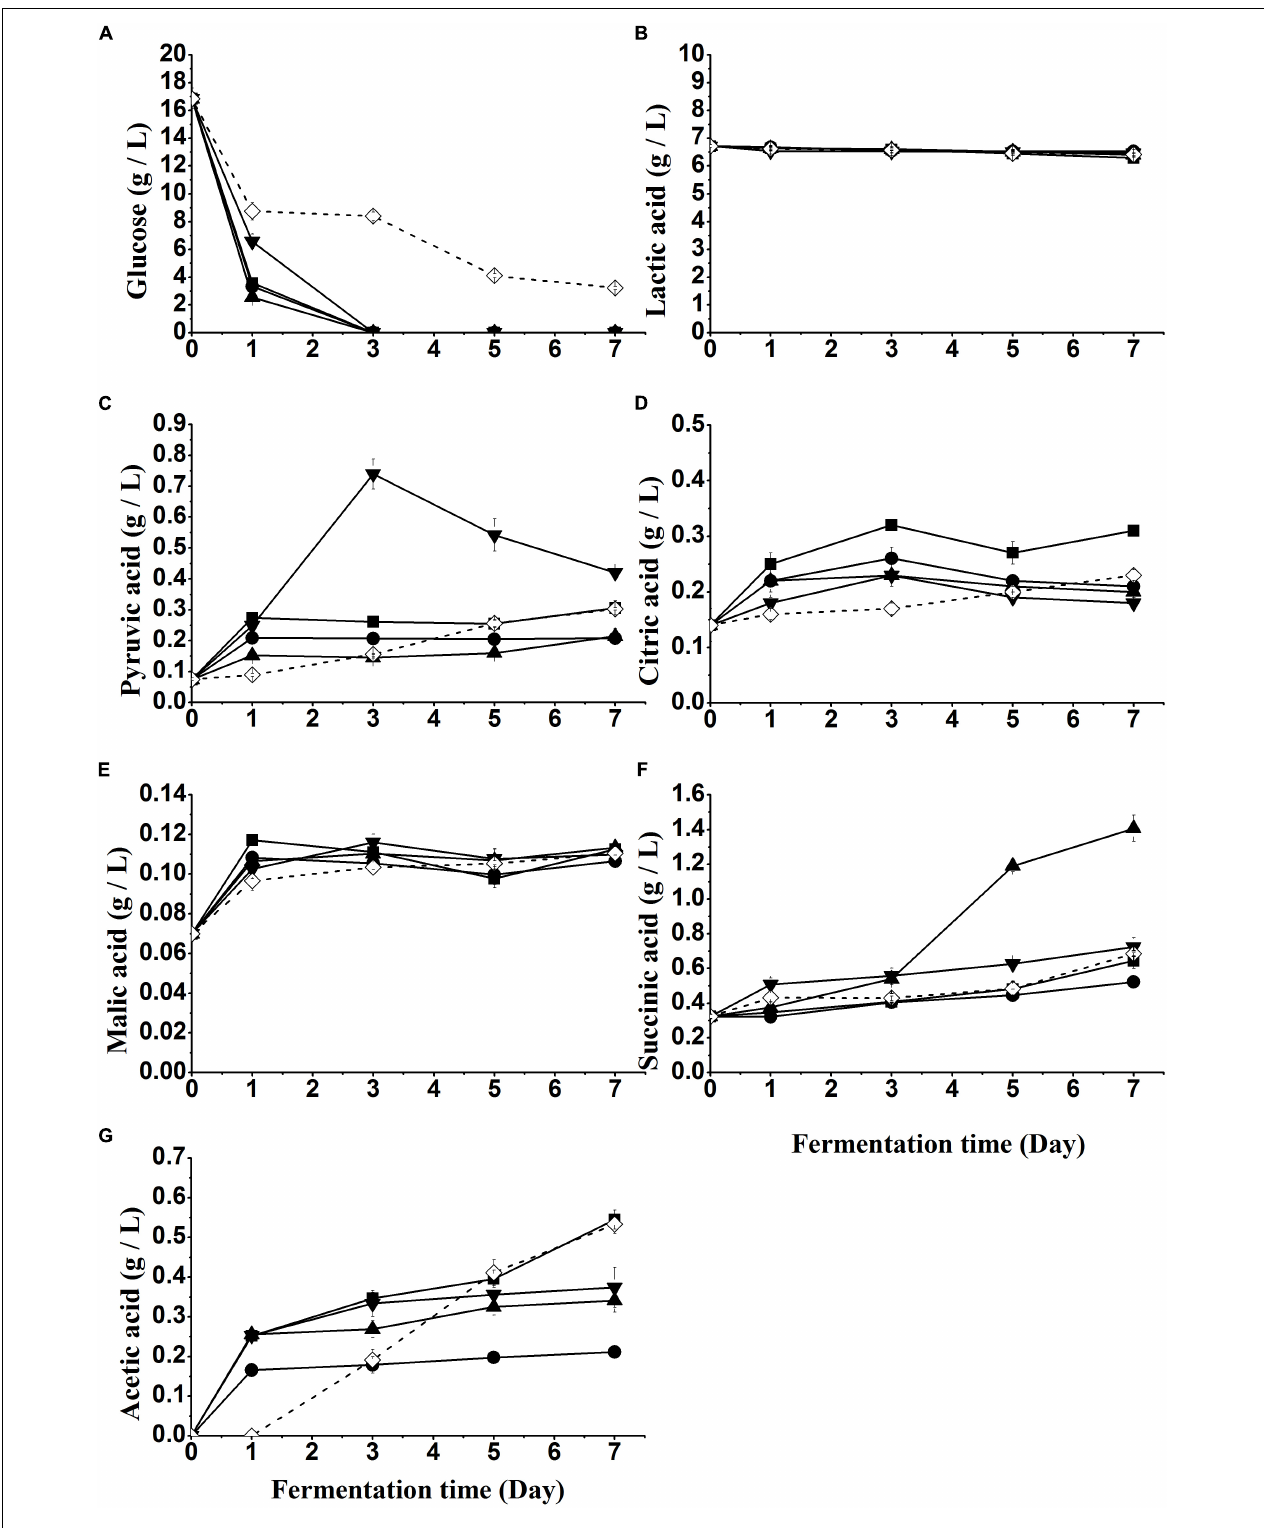
FIGURE 3 | Glucose (A) and organic acids (B–F) changes of fish sauce during fermentation with different yeasts. S1 ( (cid:4) ): inoculated with Kluyveromyces marxianus NCYC1425; S2 ( ): inoculated with Torulaspora delbrueckii Biodiva; S3 ( (cid:78) ): inoculated with Saccharomyces cerevisiae Lalvin EC-1118; S4 ( (cid:72) ): inoculated with Pichia kluyveri Frootzen; S5 ( ♦ ): inoculated with Candida versatilis (cid:32)